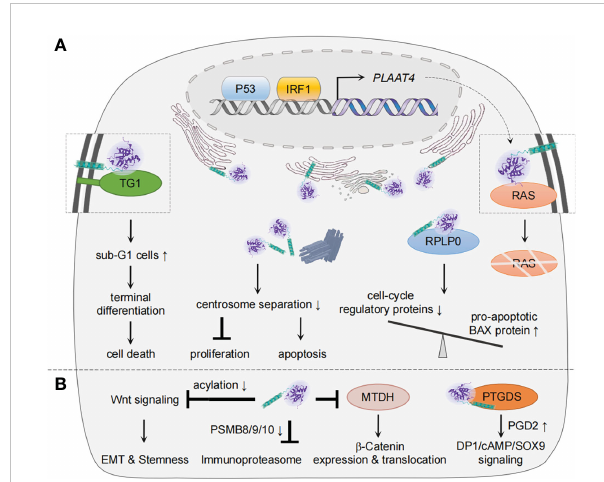
FIGURE 3 Mechanisms of PLAAT4 action during tumorigenesis and metastasis. (A) Nuclear p53 and IRF1 drive the basal expression of PLAAT4, which acts to regulate differentiation, proliferation, apoptosis, etc. to suppress tumorigenesis. The subcellular locations of PLAAT4 are shown, with a PLAAT4 structure predicted with alphaFold (105, 106). (B) PLAAT4 contributes to inhibition of epithelial-mesenchymal transition (EMT), cancer cell stemness, immunoproteasome, and b - Catenin expression and translocation, but induces prostaglandin D2 (PGD2)-mediated activation of DP1/cAMP/SOX9 signaling to suppress metastasis. For protein interactions where the subcellular location has not been identi fi ed, the illustration only depicts a physical interaction between PLAAT4 and target